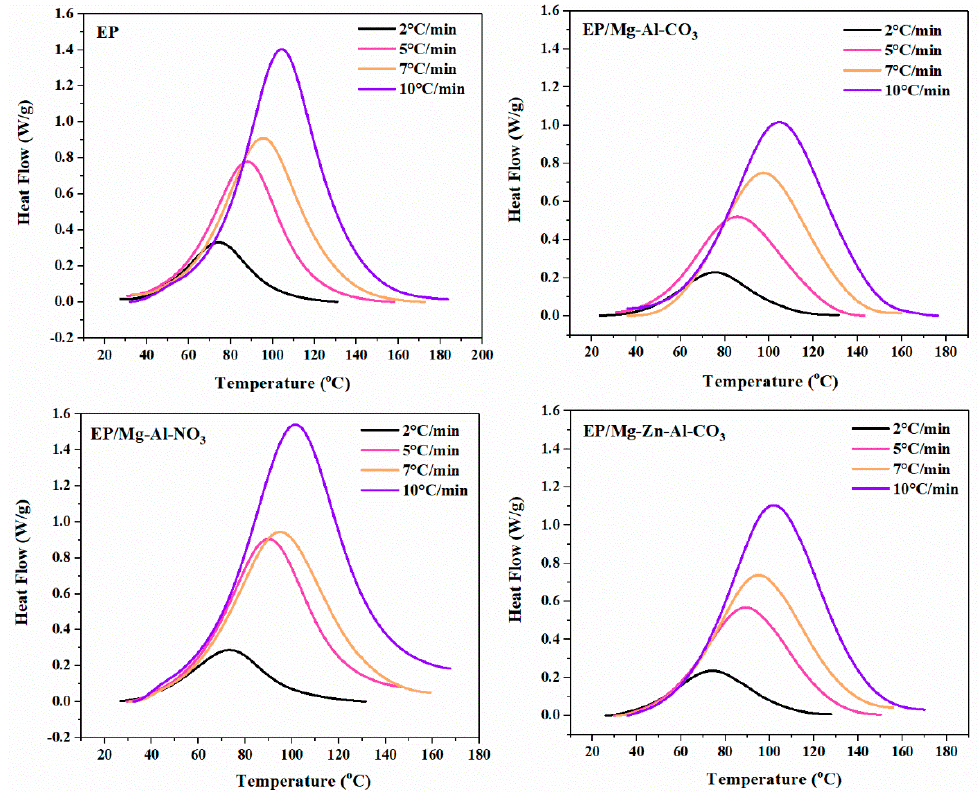
Figure 1. DSC thermograms of the neat epoxy (EP), EP/Mg-Al-CO 3 , EP/Mg-Al-NO 3 and EP/Mg-Zn-Al-CO 3 nanocomposites at heating rates of 2, 5, 7 and 10 °C ∙ min − 1